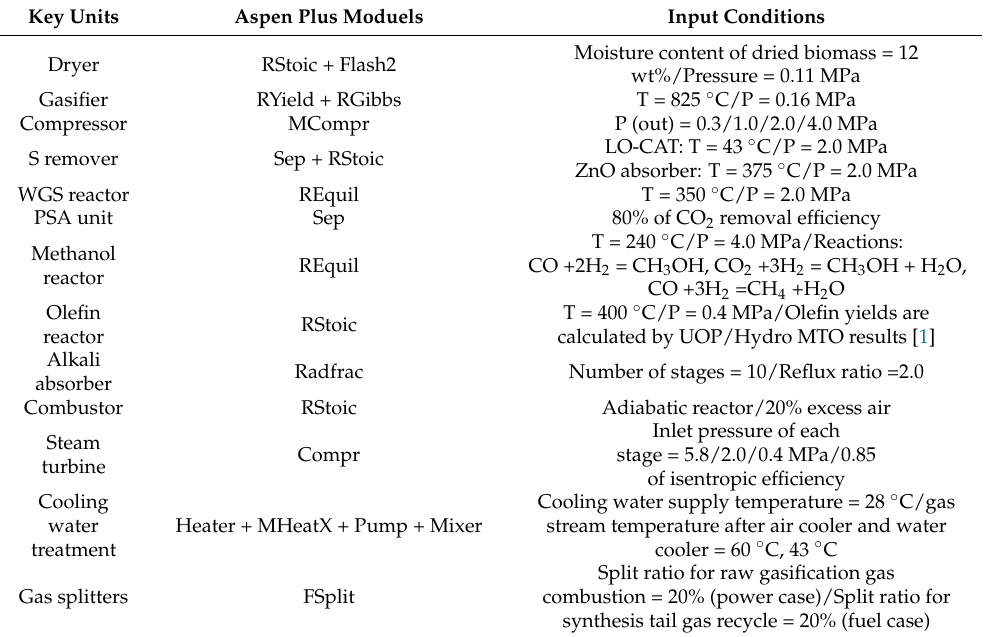
Table 2. The major operating parameters and model assumption of biomass-olefin